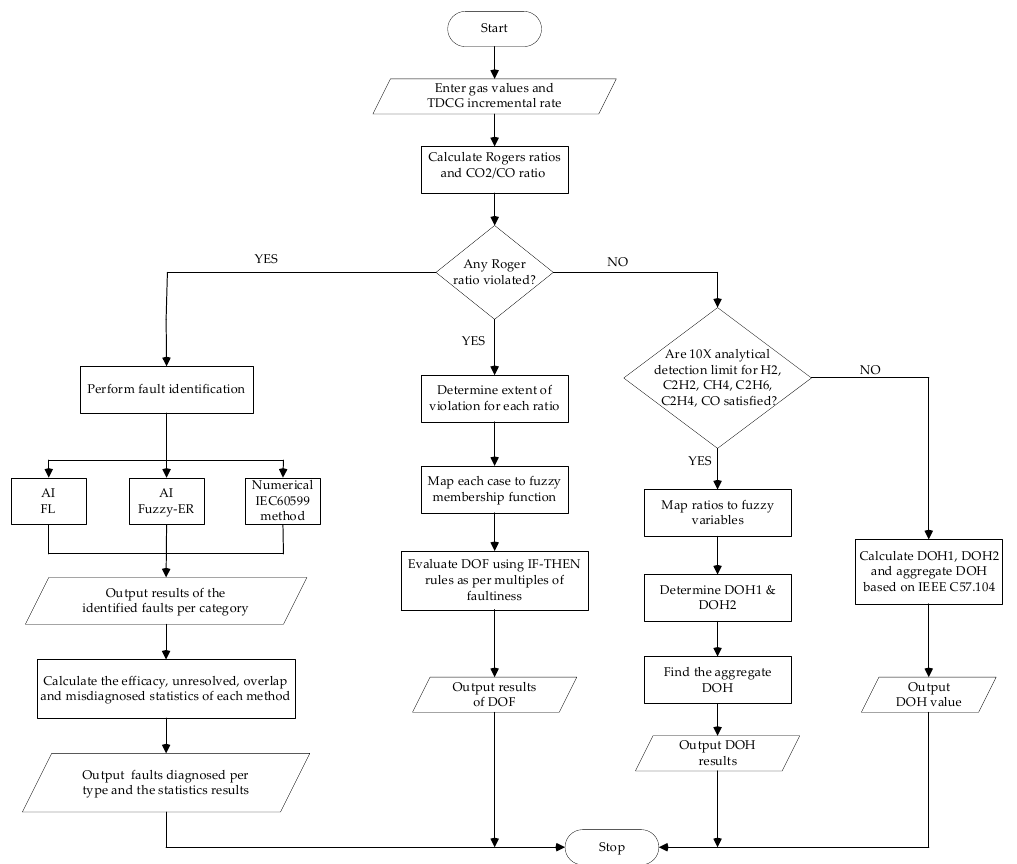
Figure 10. Flowchart for the algorithm used in MATLAB Simulink degree of healthiness (DOH), DOF, and fault diagnosis evaluation. Table 4. Typical transformers with degree of healthiness (DOH) calculated. TDCG: Total Dissolved Combustible Gases.